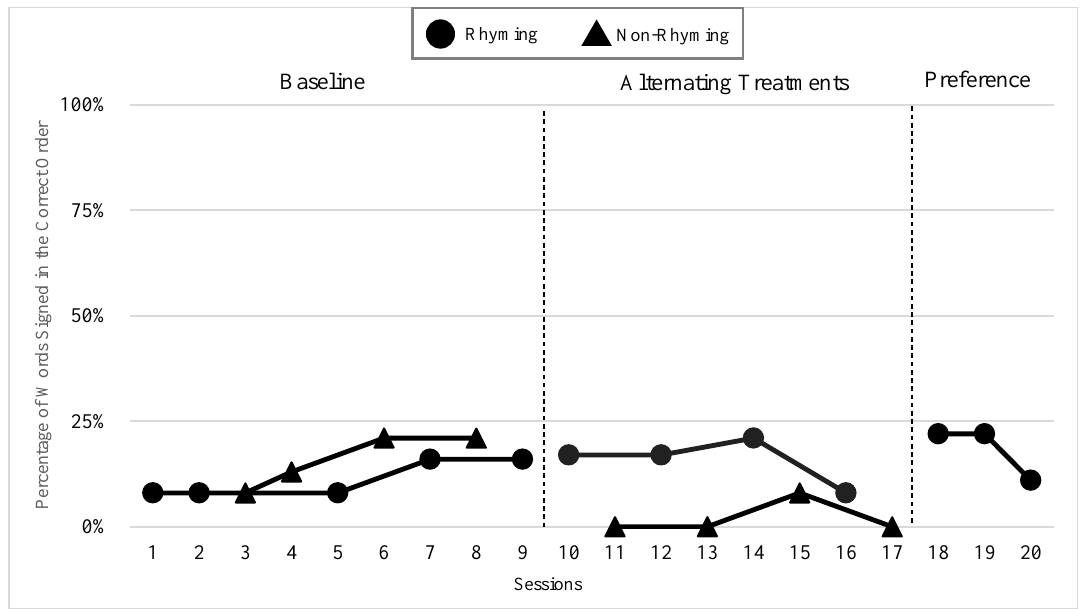
Figure 8. Daya’s Percentage of Words Signed in the Correct Order in Recitation.